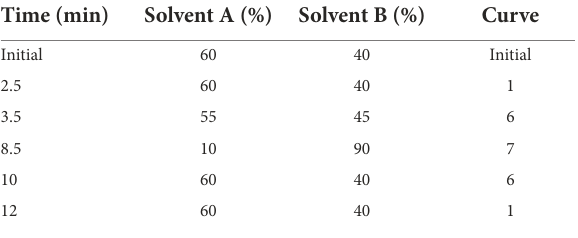
TABLE 1 Gradient program used for the liquid chromatography– tandem mass spectrometry (LC–MS/MS) at a constant flow rate of 0.25 ml/min.